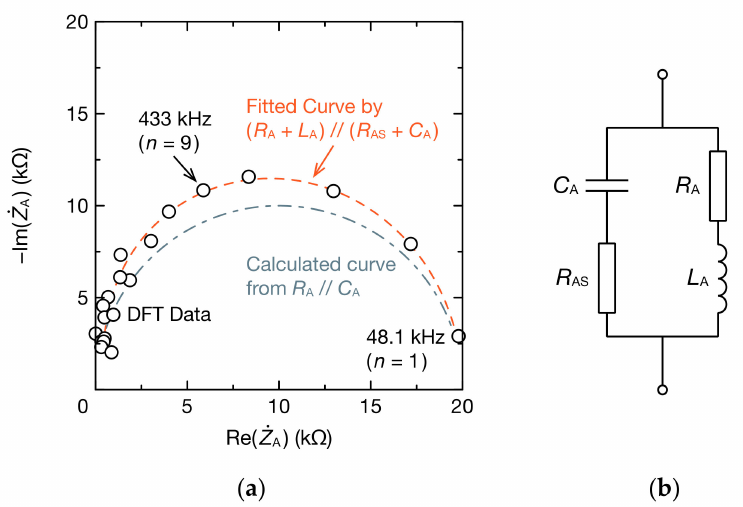
. Z A : ( a ) Cole–Cole plot for C X = 0.10 nF and R X = 0 Ω ; Figure 9. Equivalent circuit modeling of ( b ) equivalent circuit with a stray resistance R AS and stray inductance L A . The symbol n represents the . Z A ( nf 0 ) . We used pyZwx software to fit the DFT data to the equivalent circuit harmonic number of model